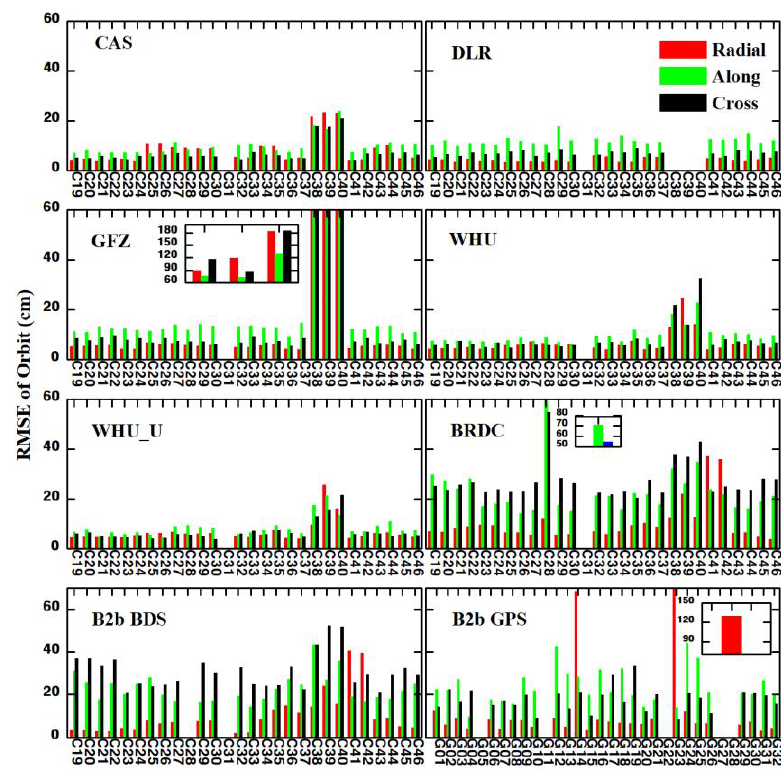
Figure 4. RMS of real-time orbit errors.